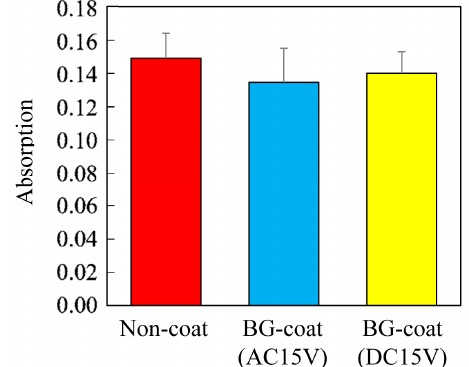
Figure 9. Absorbance at 450 nrn as a function of the L929 fibroblast cell number at 36 h.